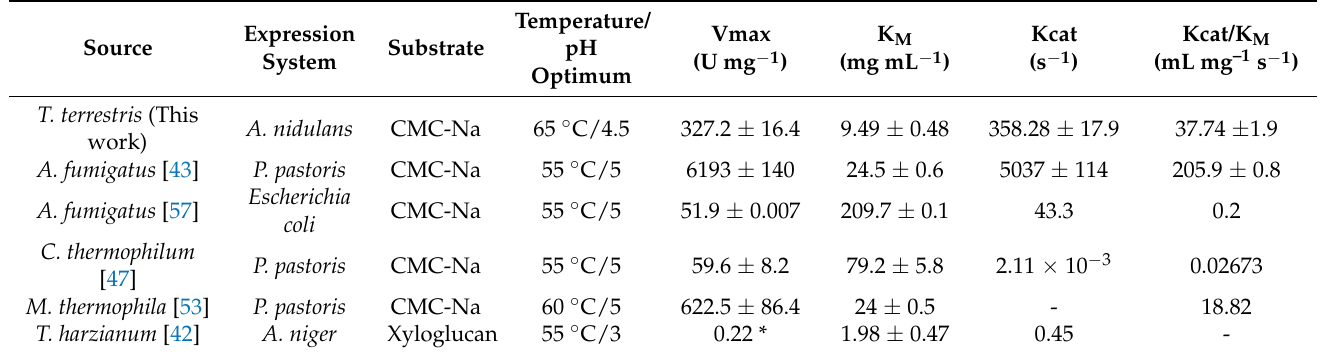
Figure 6. Effect of temperature and pH on Tt Cel7B activity and stability. ( A ) The effect of temperature on activity was determined with CMC as the substrate, at pH 4.0; ( B ) effect of pH on activity, at 65 ◦ C. Key: ( • ) citrate buffer, ( (cid:78) ) phosphate buffer, ( (cid:4) ) tris-HCI buffer. ( C ) Tt Cel7B was incubated for 48 h at temperatures of 45 ◦ C ( • ), 50 ◦ C ( (cid:3) ), 55 ◦ C ( (cid:78) ), 60 ◦ C ( ), and 65 ◦ C ( (cid:4) ). Residual activity (cid:35) corresponding to the activity before incubation (100%); ( D ) stability at different pH values for 24 h, with 100% of residual activity corresponding to the activity at pH 4.0. Key: ( • ) citrate buffer, ( (cid:78) ) phosphate buffer, ( (cid:4) ) tris-HCl buffer. Results were expressed as the average of triplicate assays ± the standard error of the mean. Table 1. General catalytic properties of Tt Cel7B compared with other